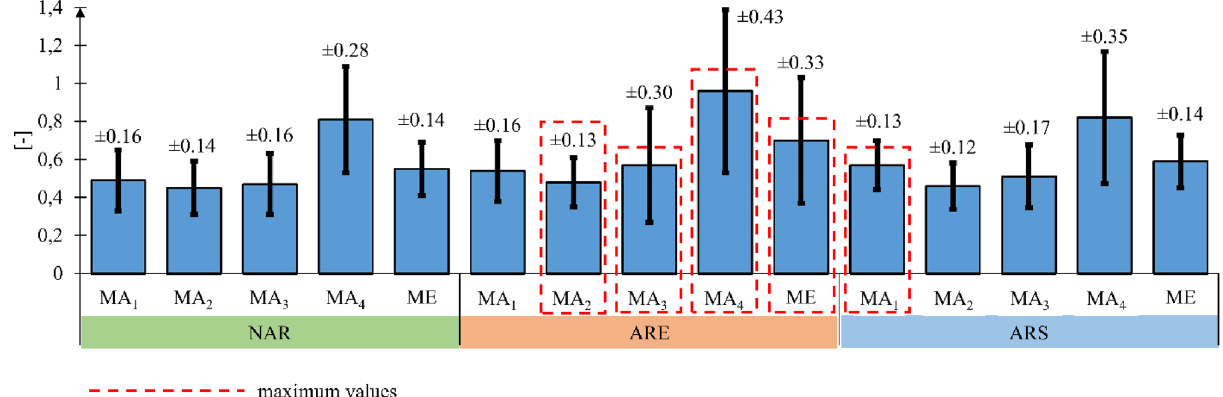
Figure 12. Results of the maximum effort (ME) and maximum muscle activity (MA) analysis for the wheelchair without the anti-rollback system (NAR), with the flexible anti-rollback system (ARE) and with the stiff anti-rollback system (ARS), where: MA 1 —maximum value of muscular activity for the deltoid muscle anterior, MA 2 —maximum value of muscular activity for the deltoid muscle posterior, MA 3 —maximum value of muscular activity for the triceps brachii muscle, MA 4 —maximum value of muscular activity for the extensor carpi radialis longus, ME—maximum value of total upper limb effort. All mean values were determined at the 95% confidence interval ( p =